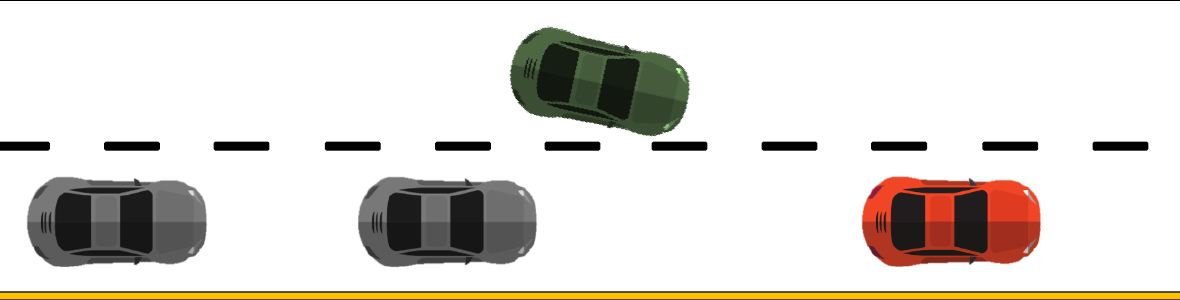
Figure 2. Platooning scenario: lead vehicle (in red) preceding the two followers (in grey) and the cut-in vehicle (in green), which is about to suddenly switch lanes.